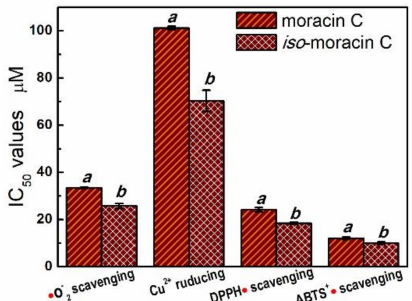
Figure 3. The IC 50 values of moracin C and iso -moracin C in antioxidant assays, including • O 2 −